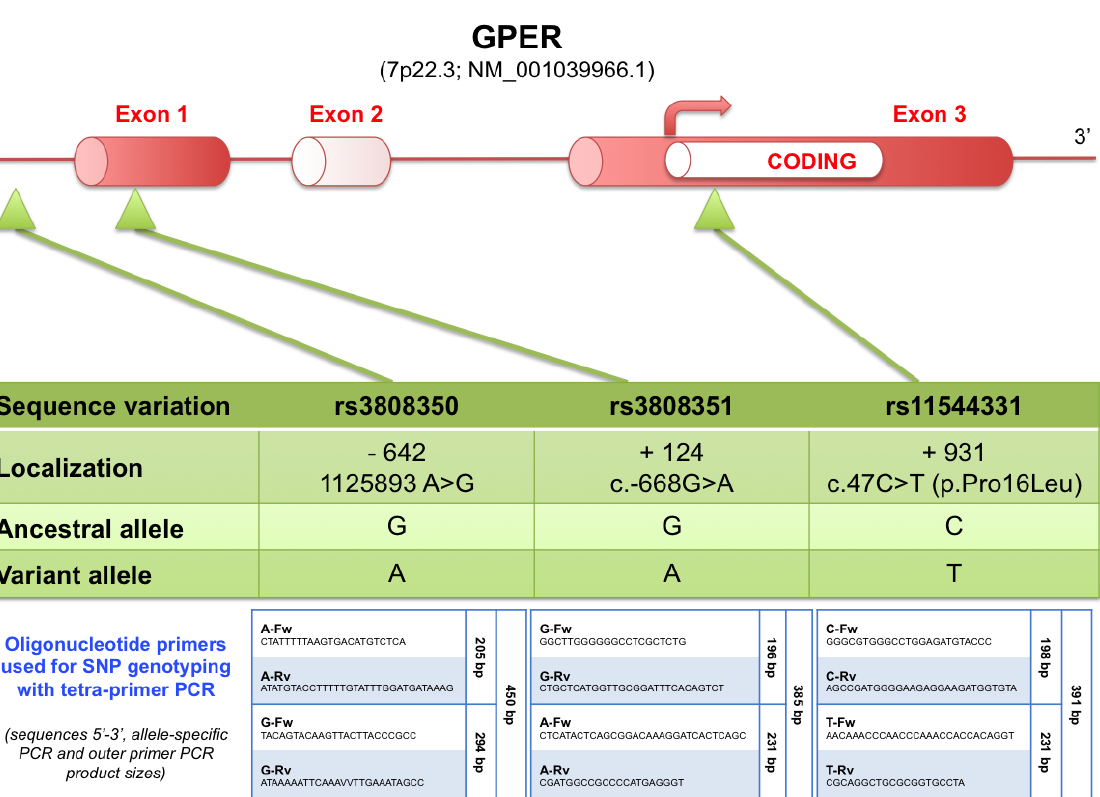
Figure 5. Localization of the three genotyped GPER SNPs with their relative position from the transcription start site and the oligonucleotide primers used for SNPs genotyping with tetra-primer PCR. Ancestral and variant alleles were determined in the HapMap project and reported on the internet database [37]. Filled boxes: untranslated region; open box: coding region; curved arrow: translation start